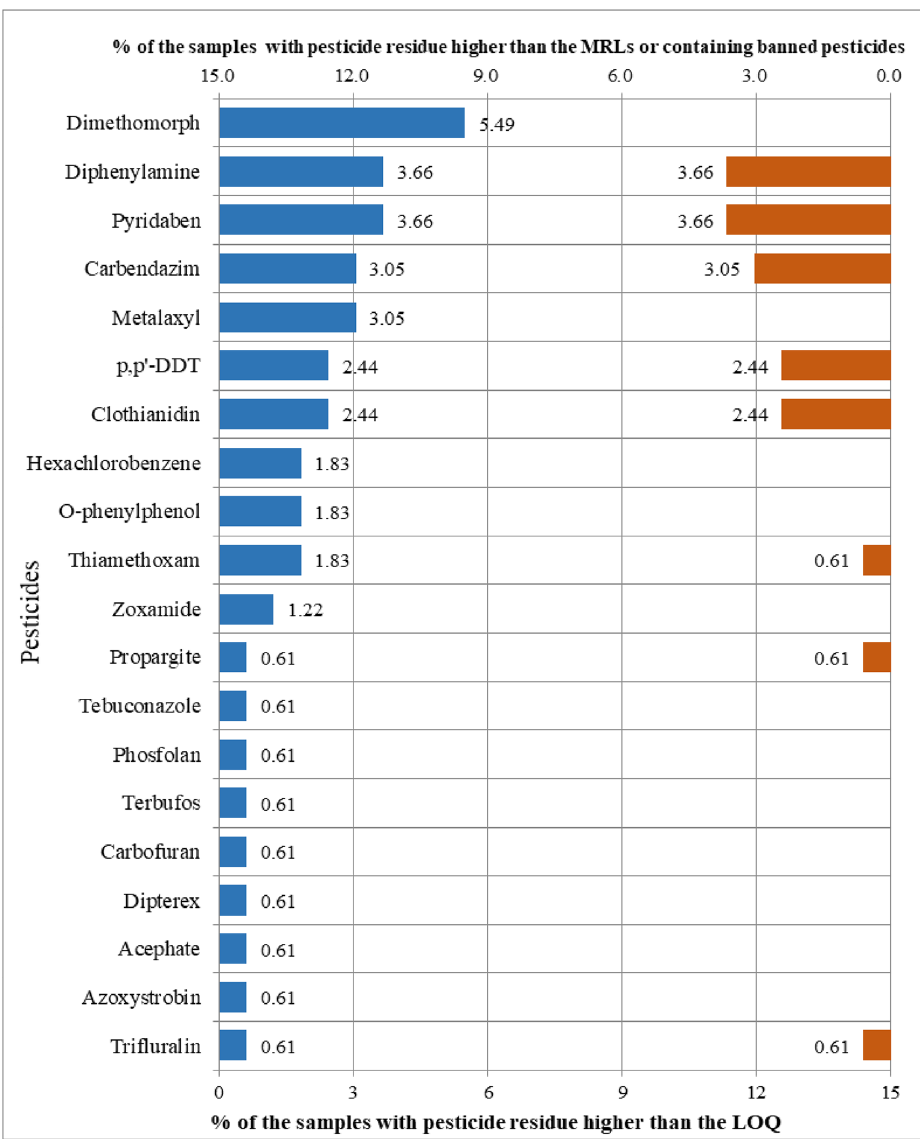
Figure 1. The percentage of pesticide residues detected in CR and the percentage of samples above the maximum detection limit. Note the blue bar indicates the proportion of the detected samples, and the results are shown at the bottom (0–15%). The red bar represents the percentage of samples above the maximum limit or containing banned pesticides, which is shown at the top